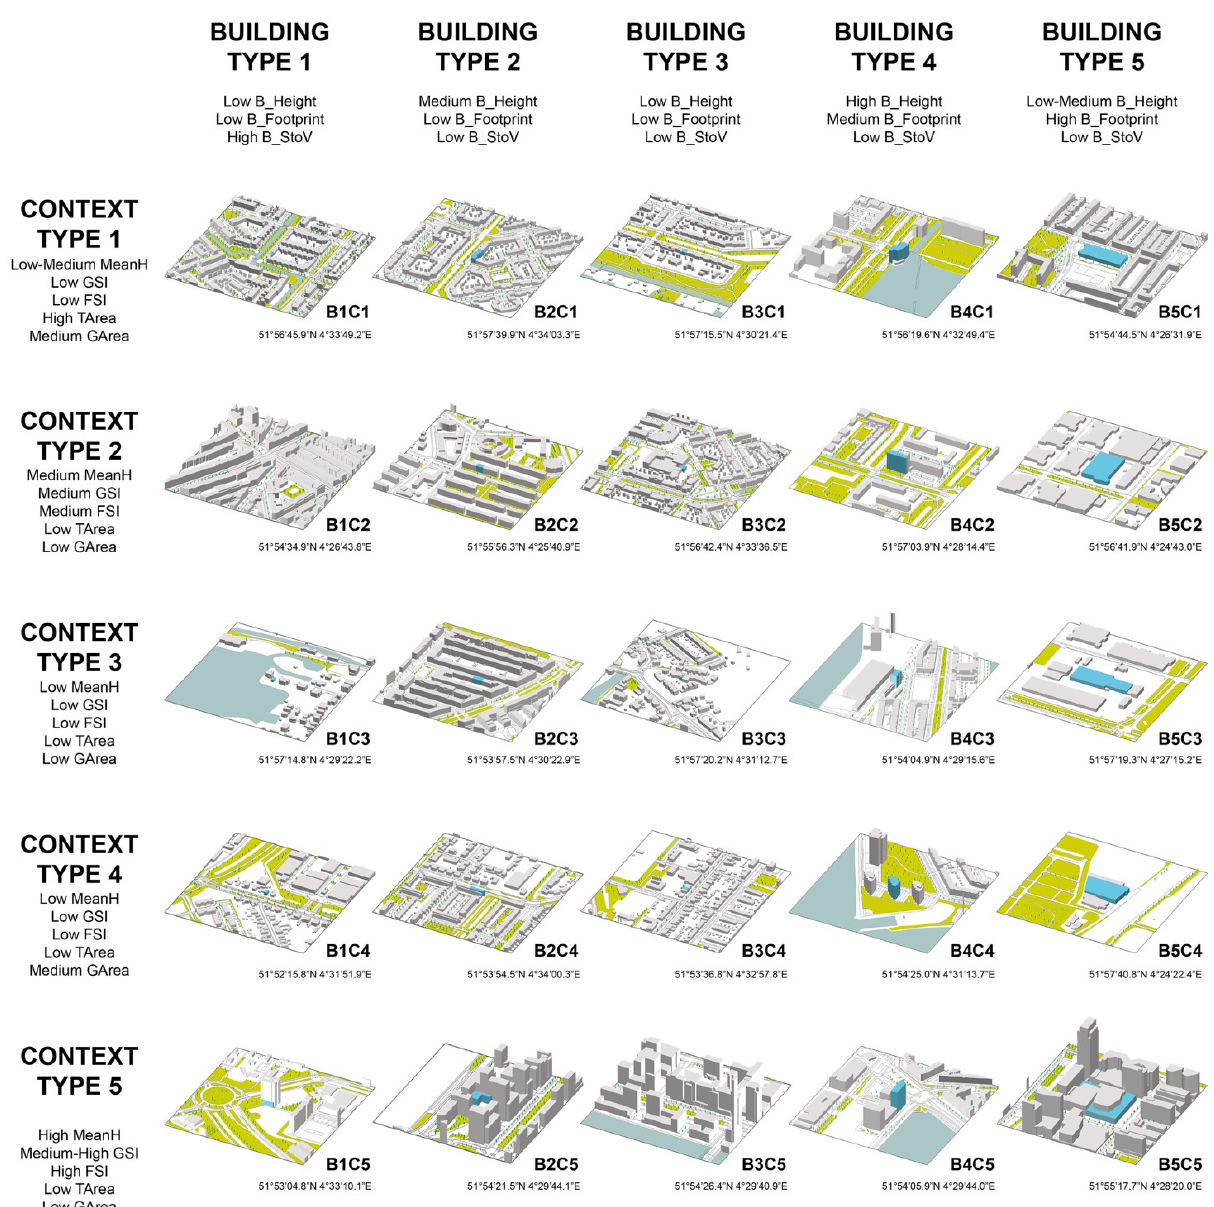
Figure 5. Visualisation of the building archetypes in the five context types. 2018). Validation studies have confirmed its high level of accuracy in modelling microclimate processes in